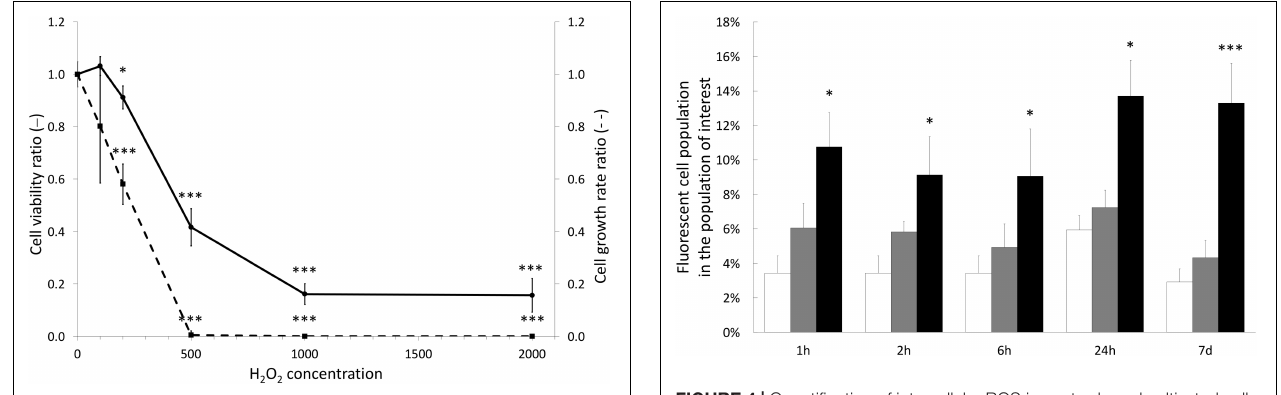
FIGURE 3 | Dose viability and growth responses of gastrodermal cultivated cells under H 2 O 2 treatments. A. viridis gastrodermal cultivated cells were treated with H 2 O 2 at different concentrations for 7 days before measuring cell viability (solid line) and cell growth rate (dashed line). Cell viability and growth rate are expressed relative to the control condition (ratio of the control condition). Means values with standard error bars are presented. Significant differences between control and stress condition are expressed by ∗ p < 0.05 and ∗∗∗ p < 0.001.